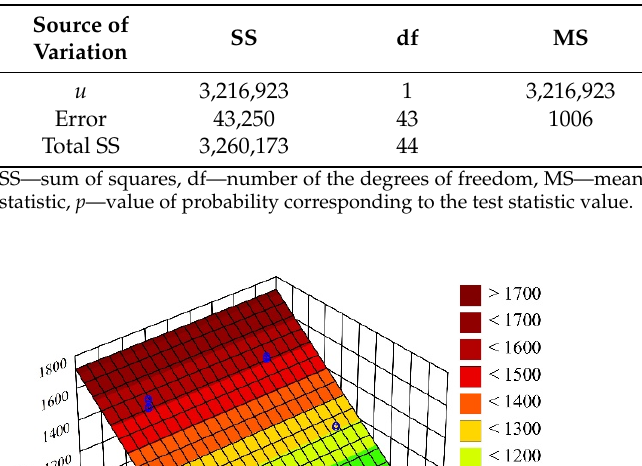
Figure 23. Response surface plot for the Young’s modulus E versus wheat bran content u and screw speed n.